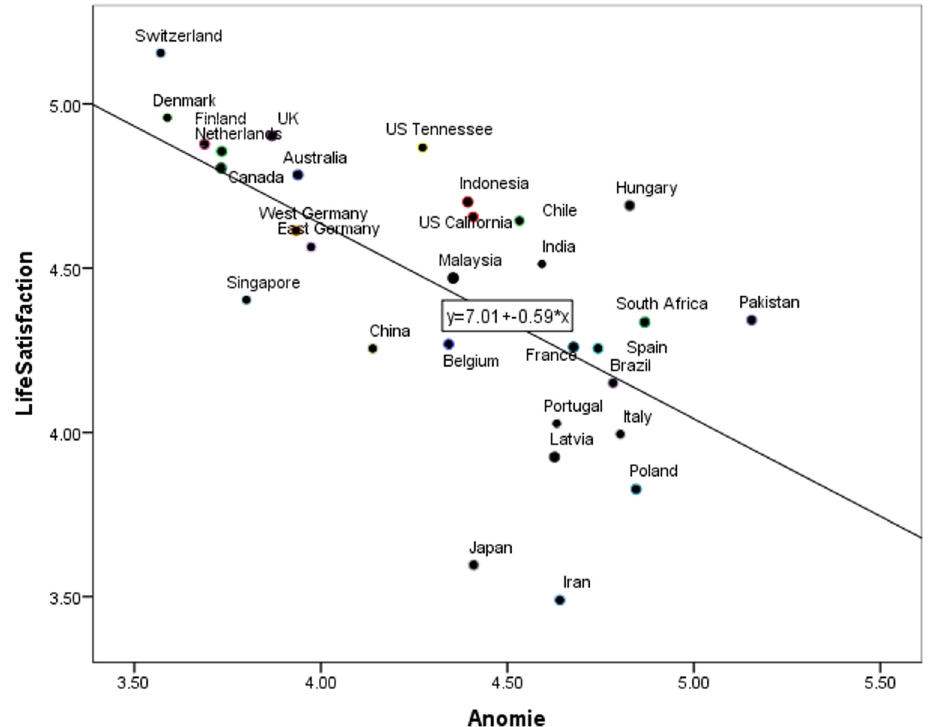
Fig 1. Relation between PAS and life satisfaction across